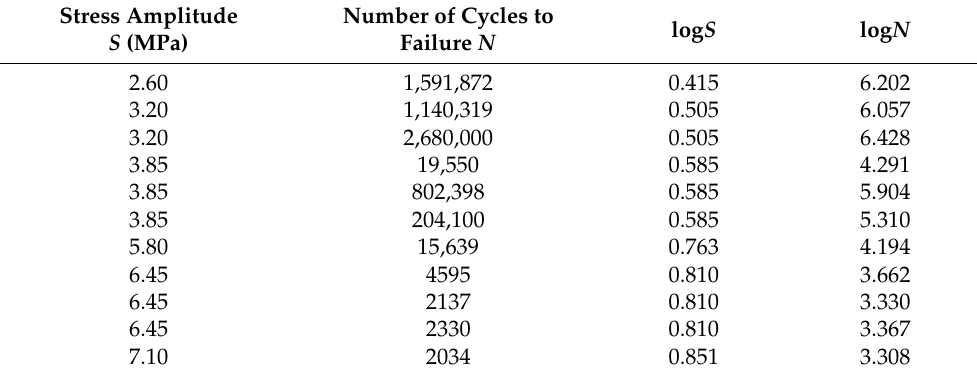
Table 5. Example test